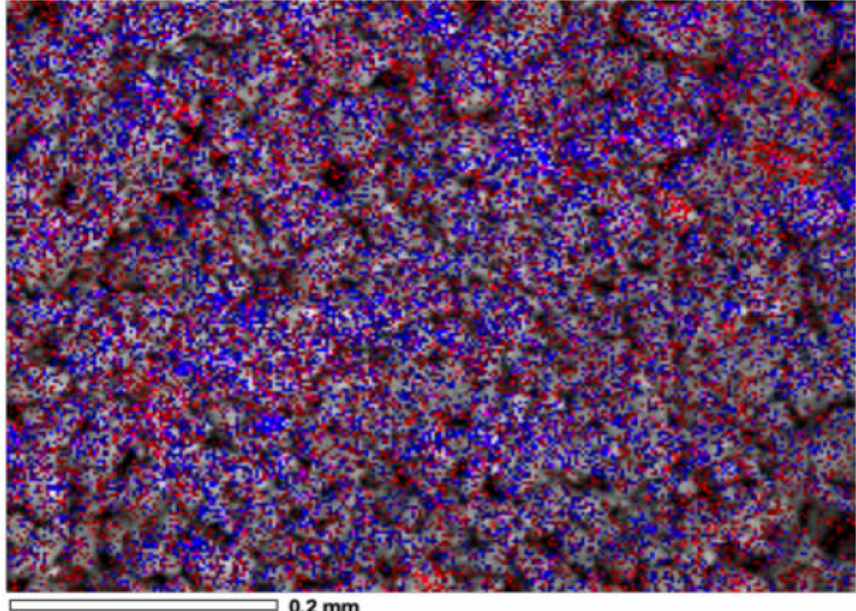
Figure 8. Overlapping EDX elemental mapping of NiWAu/ACT1 nanomaterial with gold at 2.5 wt%.